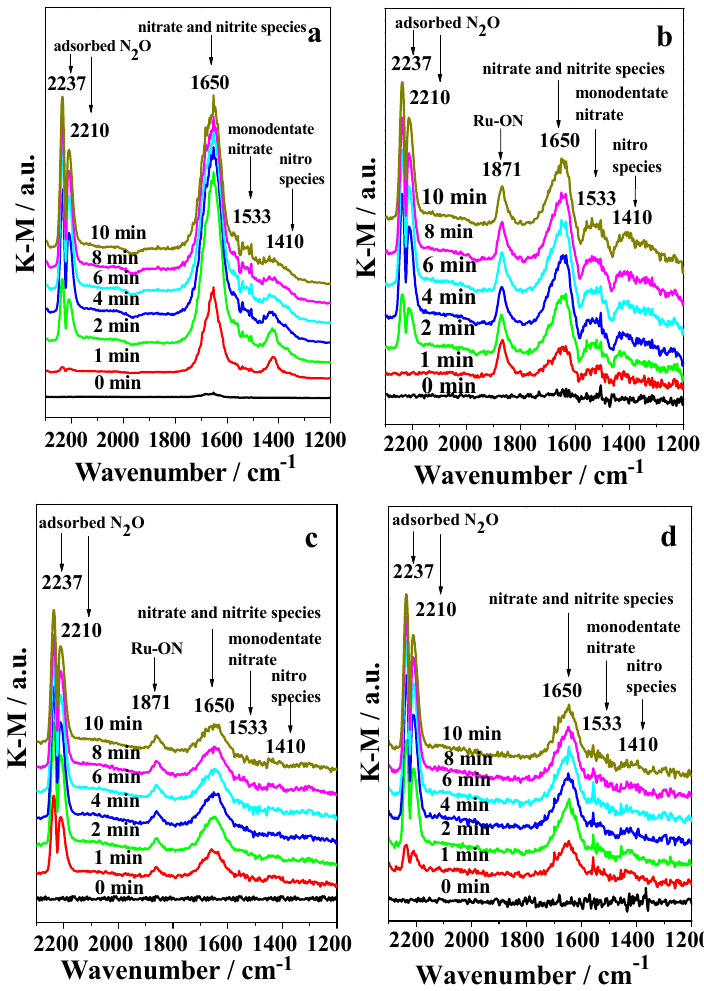
Figure 9. DRIFTS of N 2 O adsorption on: ( a ) Al 2 O 3 ; ( b ) Ru/Al 2 O 3 ‐ NaBH 4 ; ( c ) Ru/Al 2 O 3 ‐ H 2 ; ( d ) Ru/Al 2 O 3 ‐ air at 50 °C. Condition: [N 2 O] = 5000 ppm.